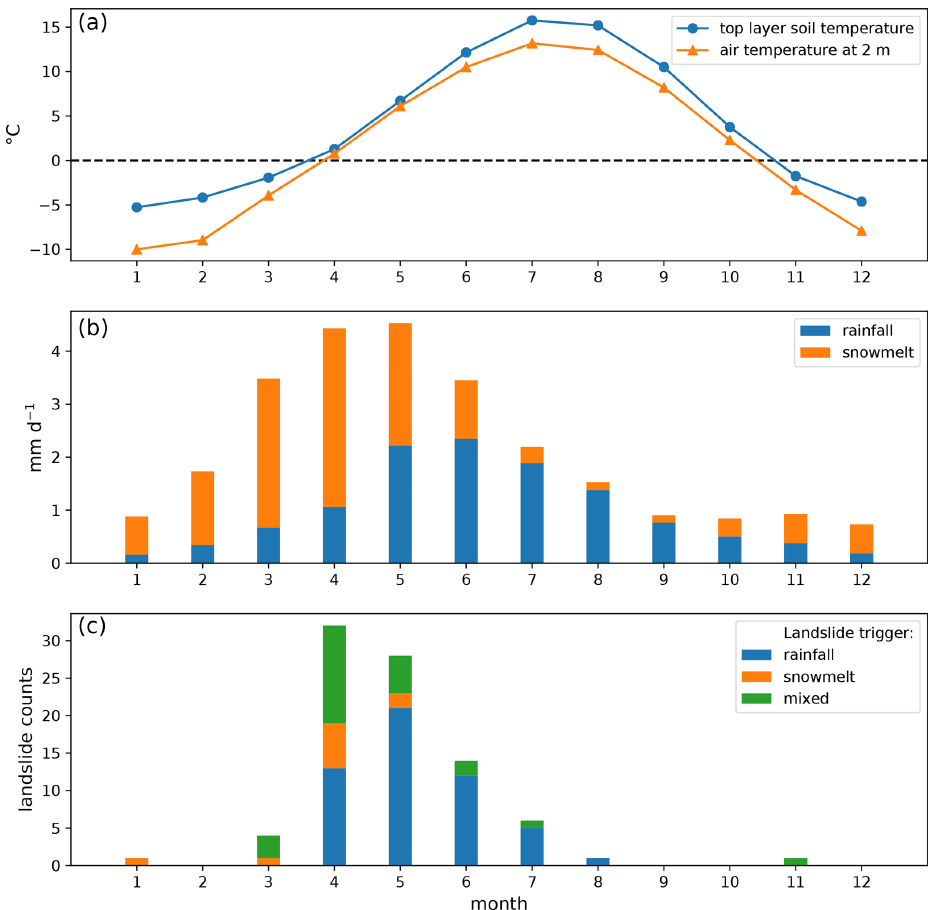
Figure 4. (a) Mean monthly soil temperature at the top soil layer (0–0.1m) and air temperature at 2m averaged over Kyrgyzstan and Tajikistan extracted from the HAR v2; (b) mean monthly rainfall and snowmelt averaged over Kyrgyzstan and Tajikistan extracted from the HAR v2; and (c) mean monthly landslide occurrences in Kyrgyzstan and Tajikistan from 2004 to